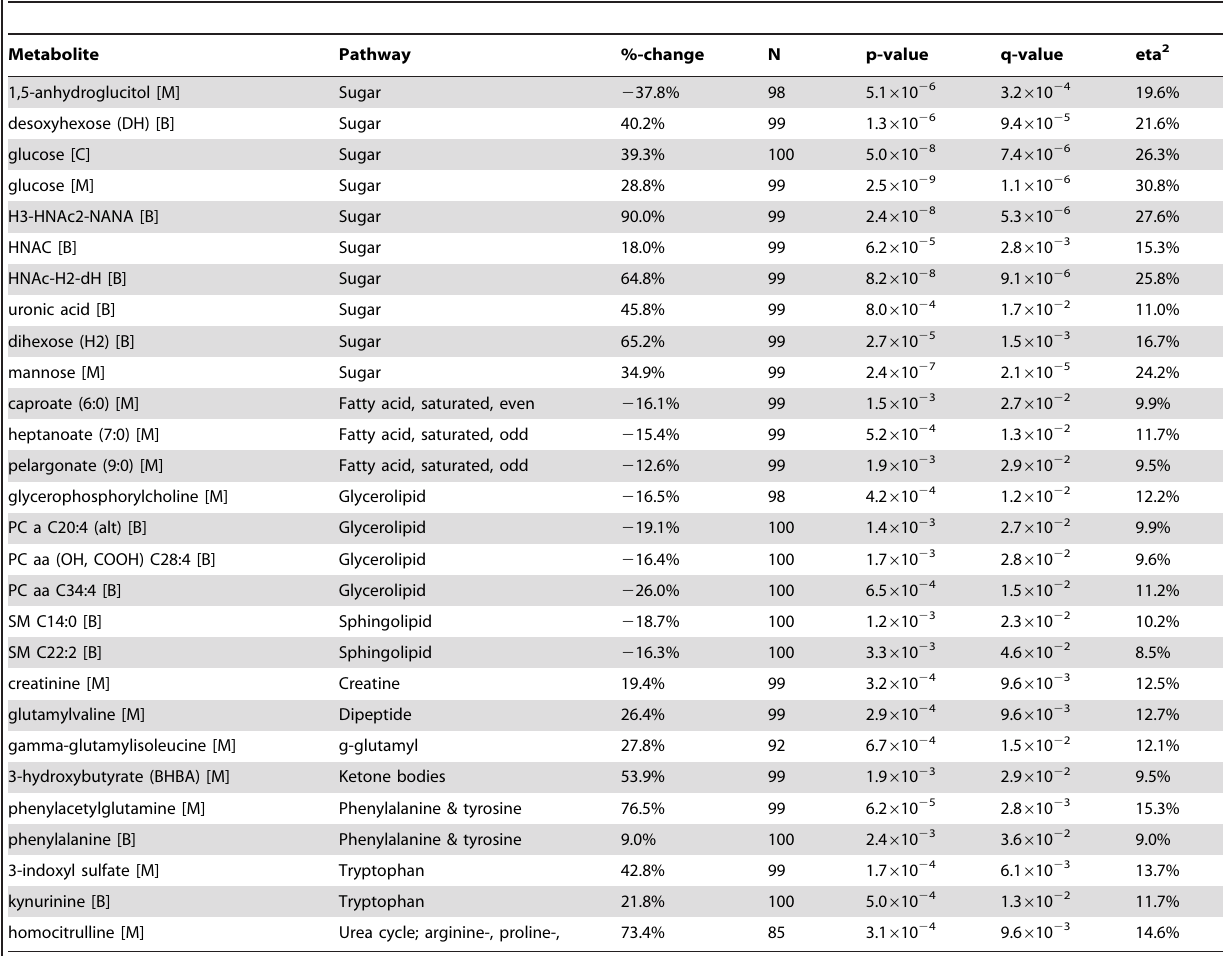
Table 2. List of selected metabolites that associate with diabetes at q-values , 0.05 using log-scaled metabolite concentrations and assuming a linear model; %change is the increase or decrease of the mean in the diabetes group with respect to the control group; eta 2 is the proportion of the total variance that can be explained by the factor ‘‘diabetes’’ in the linear model; N is the number of valid data points that entered the analysis; the platform on which the corresponding metabolite was measured is indicated by the first letter of the provider: B= Biocrates, C =Chenomx, M